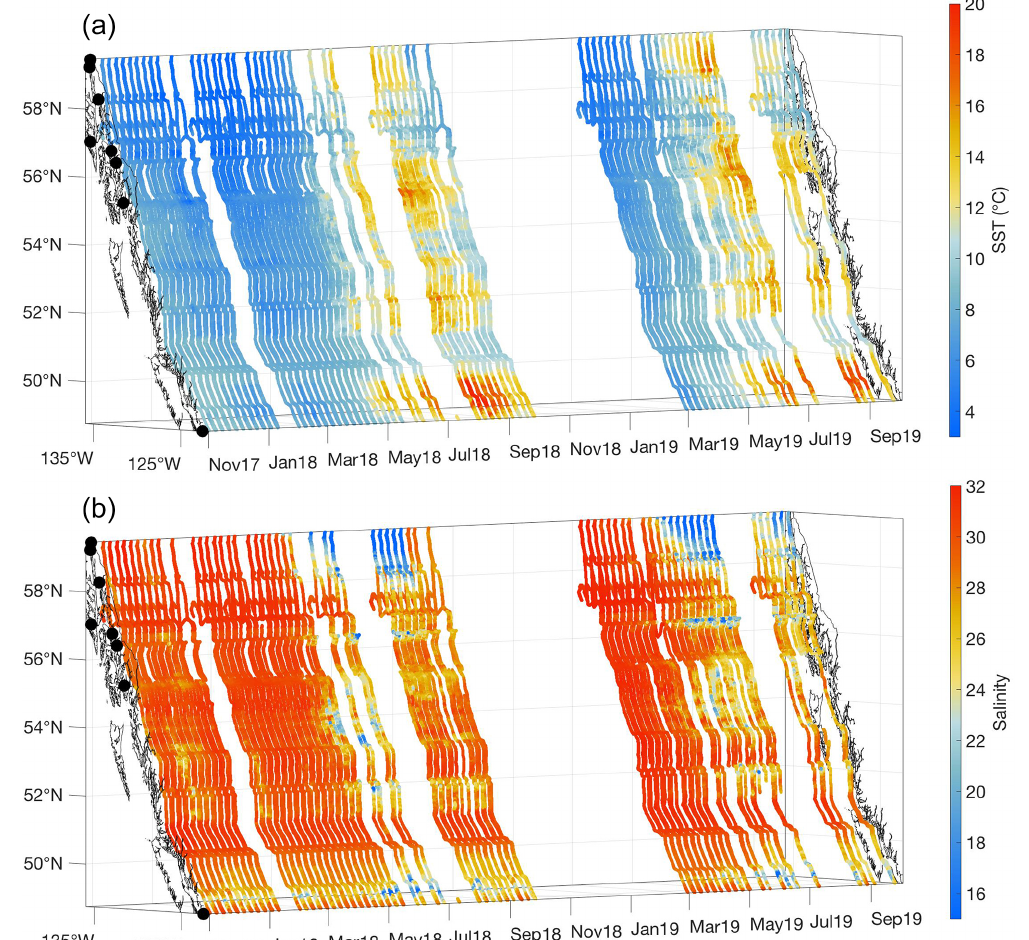
Figure 2. Sea surface temperature (SST; ◦ C; a ) and salinity (b) measured between 3 November 2017 and 2 October 2019. The x and y axes represent longitude and latitude, respectively, and with the coastline and terminal positions shown as in Fig. 1 and time increasing along the z